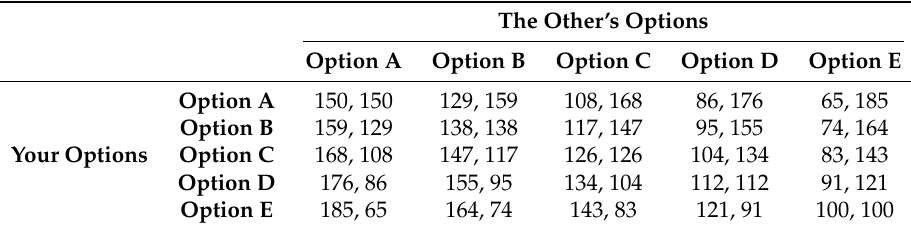
Table A5. Recomposition of task number four into a matrix game.